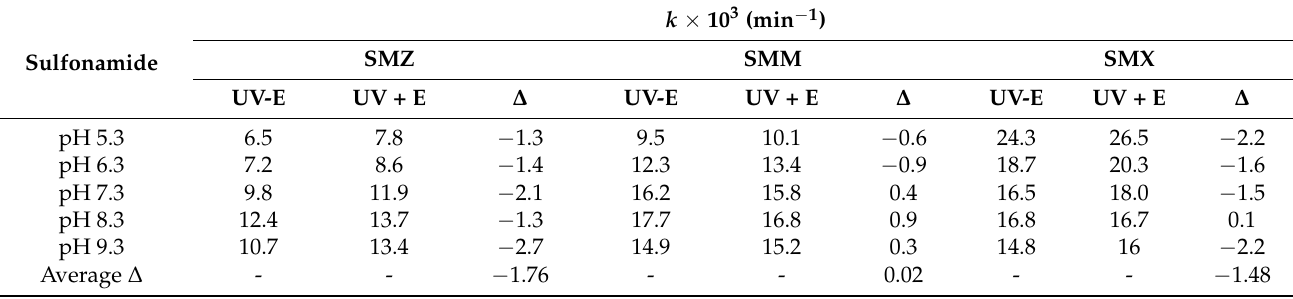
Table 2. The k values in different treatment systems (values under “UV + E” are the sums of the k values in the UV and E systems, ∆ is the difference in the k values between the UV-E system and UV +